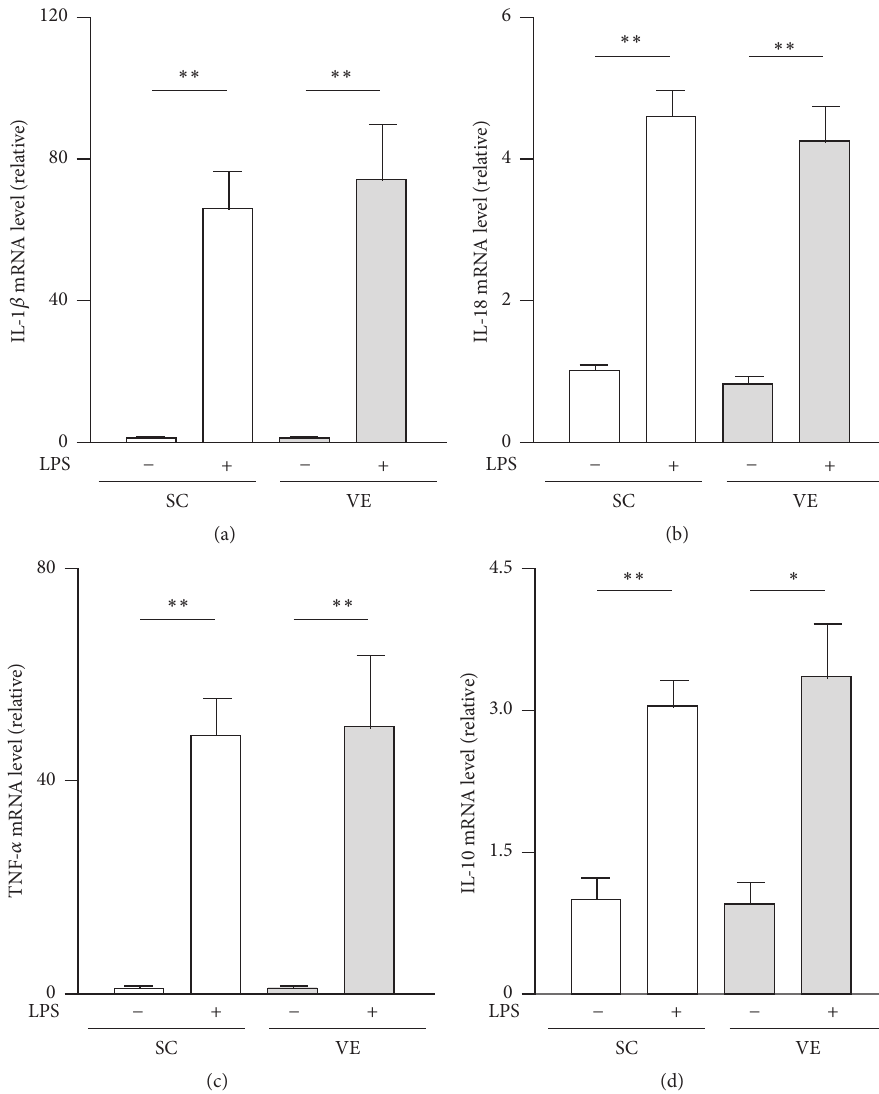
Figure 4: Effects of regular voluntary exercise (VE) on the mRNA levels of pro- and anti-inflammatory cytokines in macrophages stimulated with or without lipopolysaccharide (LPS). Peritoneal-exudate macrophages isolated from the sedentary control (SC) and VE mice were cultured for 6 h in the presence or absence of 100ng/mL LPS. The mRNA levels of interleukin- (IL-) 1 𝛽 (a), IL-18 (b), tumor necrosis factor- (TNF-) 𝛼 (c), and IL-10 (d) were analyzed by real-time polymerase chain reaction (PCR). The mRNA levels are presented as ratios relative to the levels of 18S rRNA. Mean ± standard error of the mean (SEM; 𝑛 = 4 ) values are provided. ∗ 𝑝 < 0.05 ; ∗∗ 𝑝 < 0.01 (by one-way analysis of variance [ANOVA] and the Bonferroni